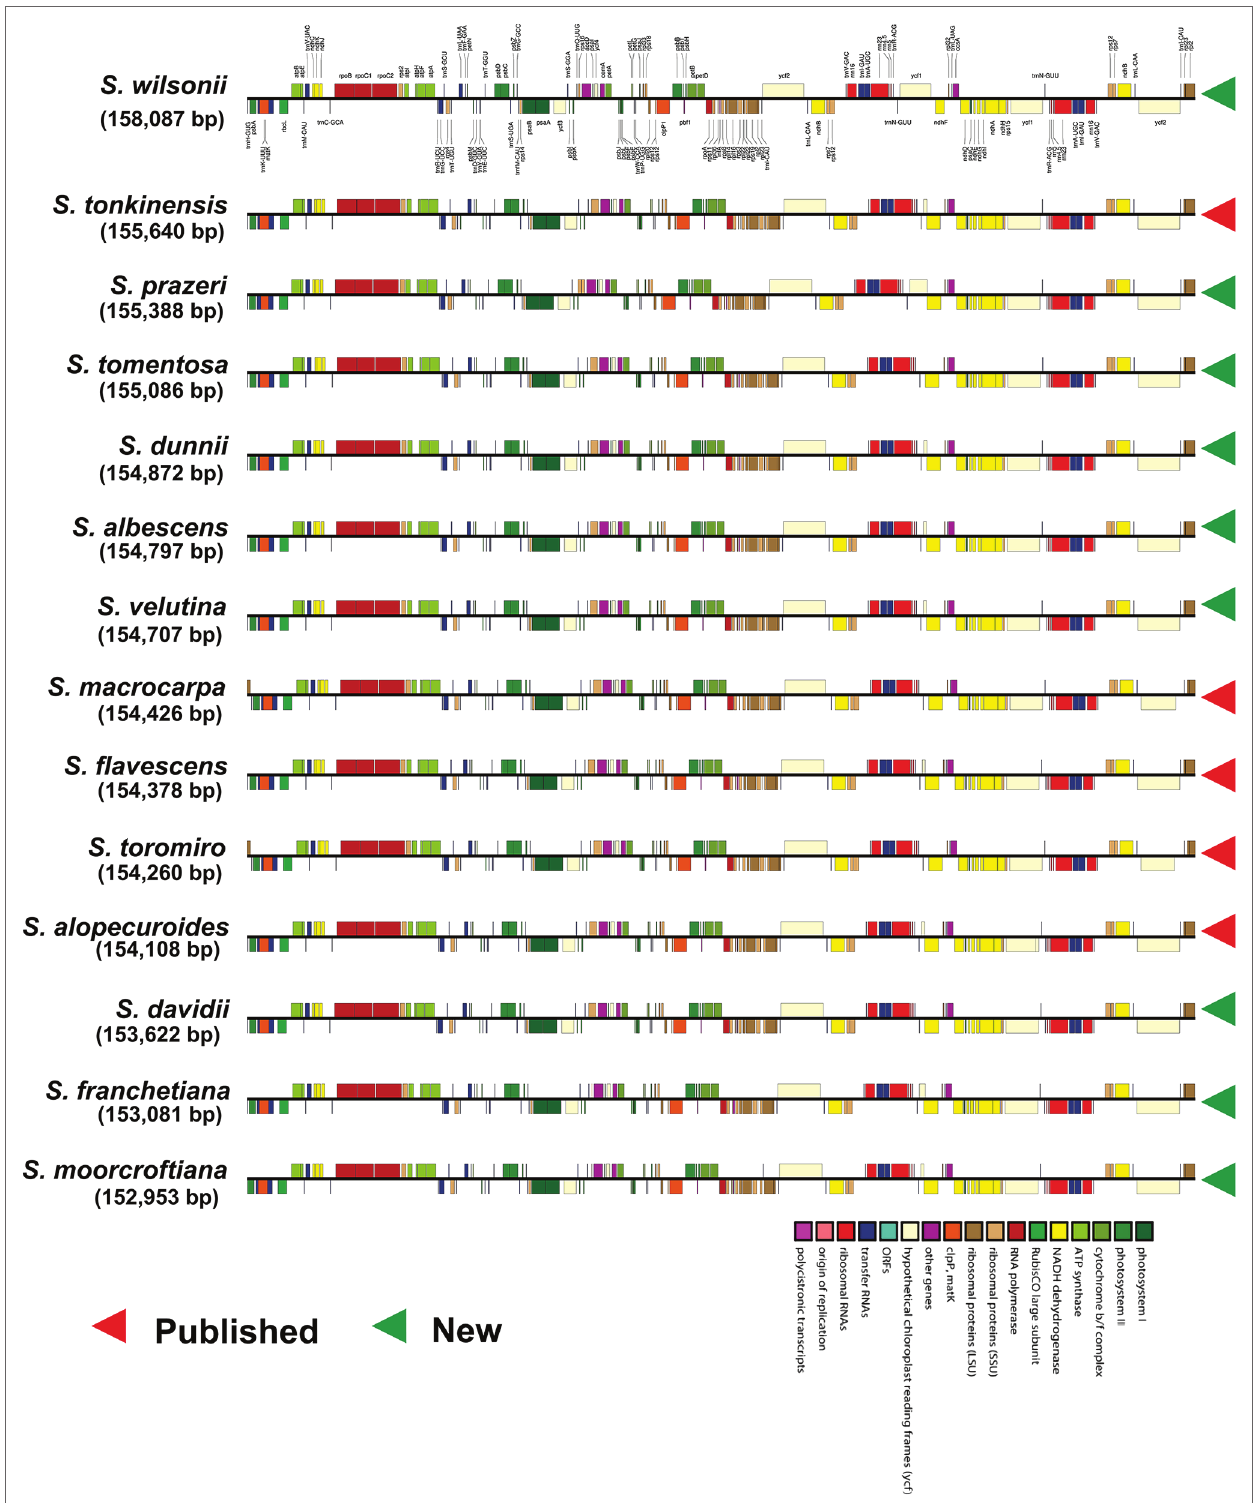
FIGURE 1 | Complete linear plastomes maps of 14 Sophora